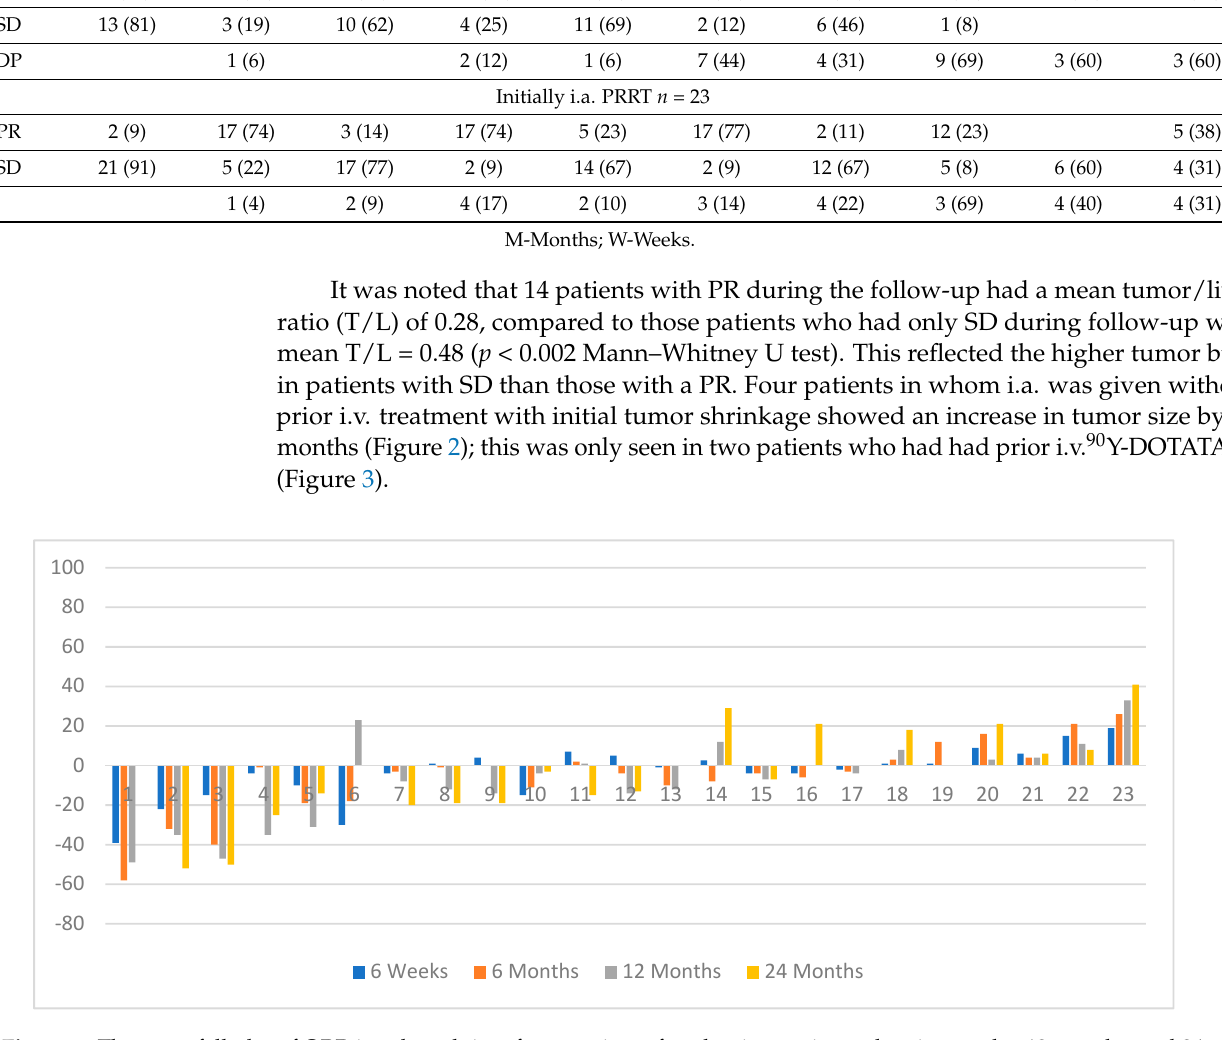
Figure 2. The waterfall plot of ORR in selected time frame points of evaluation at six weeks, six months, 12 months, and 24 months in the group with initially i.a.PRRT ( n =